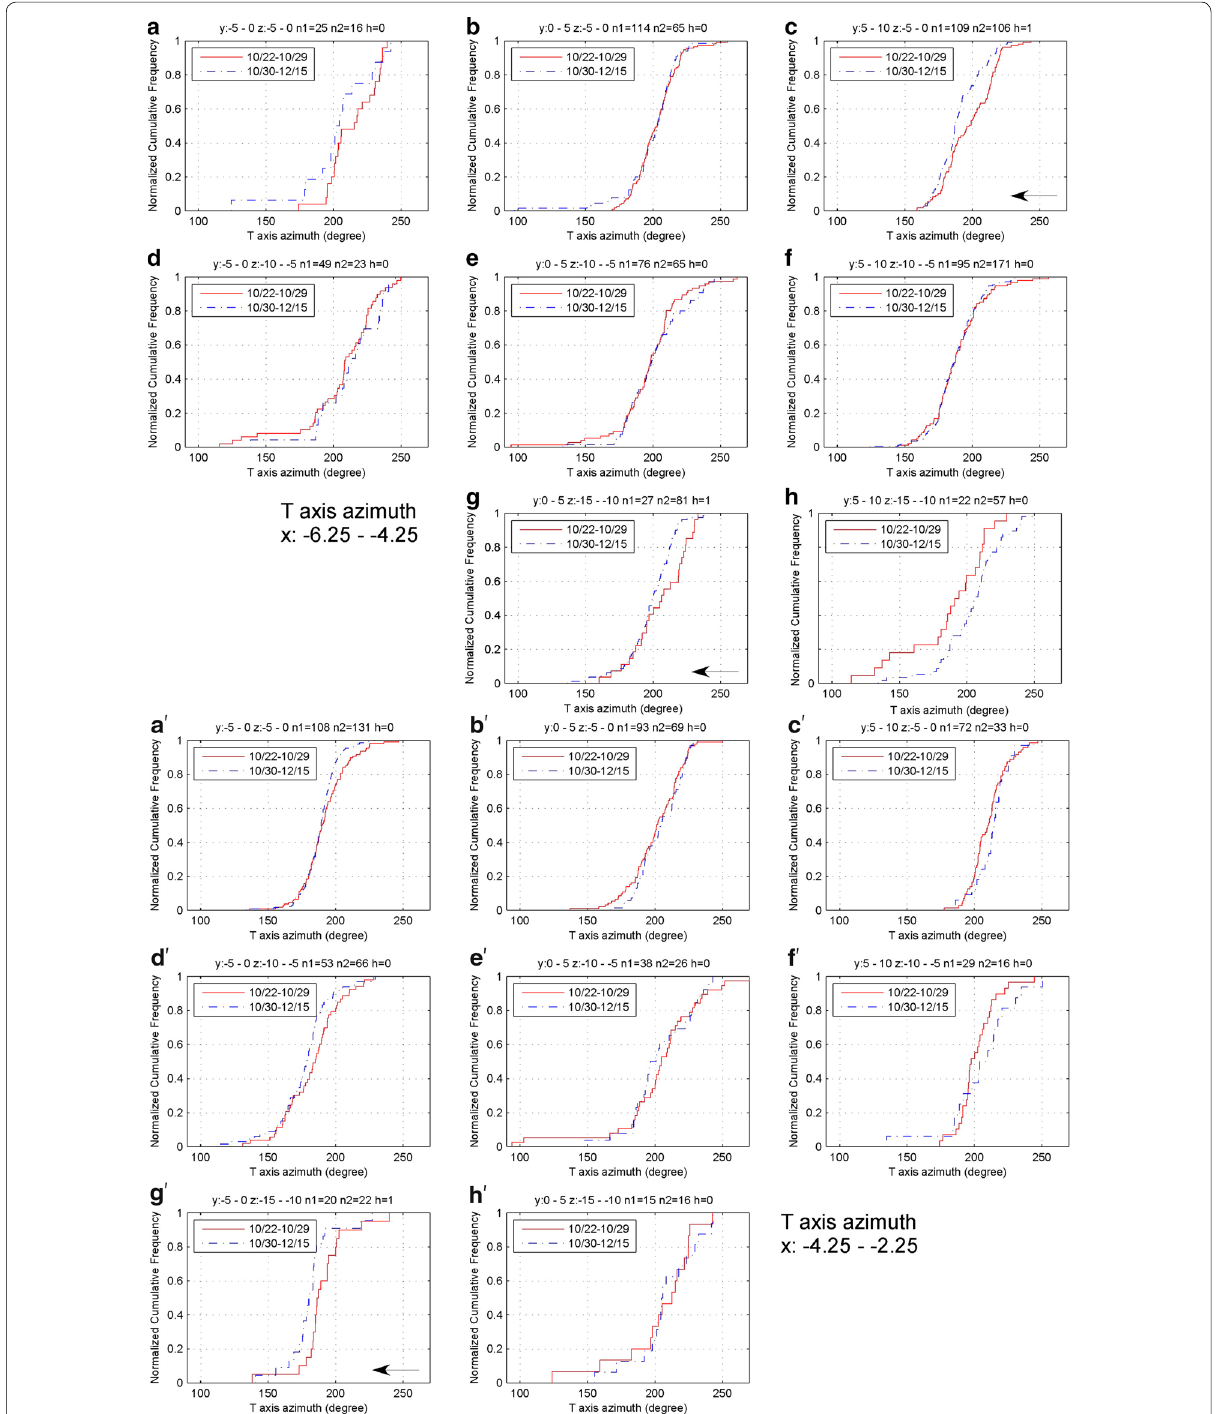
Fig. 4 Cumulative frequency distributions of T-axis azimuths for the two periods (October 22–29 and October 30–December 15) for 18 subregions and results of the KS-test. The aftershock area was divided into 9 subregions of a length of 5 km by 5 km in the Y and Z directions in the western side in a – i , and in the eastern sides in a ʹ – i ʹ . Each panel is harmoniously juxtaposed with the actual position in the vertical section along the fault plane. The position occupied by each area is indicated by a range of coordinates on the upper side of each panel. The number of data for the two periods is also shown there. Relative cumulative frequency distributions of T-axis azimuths in the former period (October 22–29) shown by red lines and those in the latter period (October 30–December 15) by blue dashed lines. Arrows indicate the subregions where the KS-test rejected the null hypothesis that the two distributions are